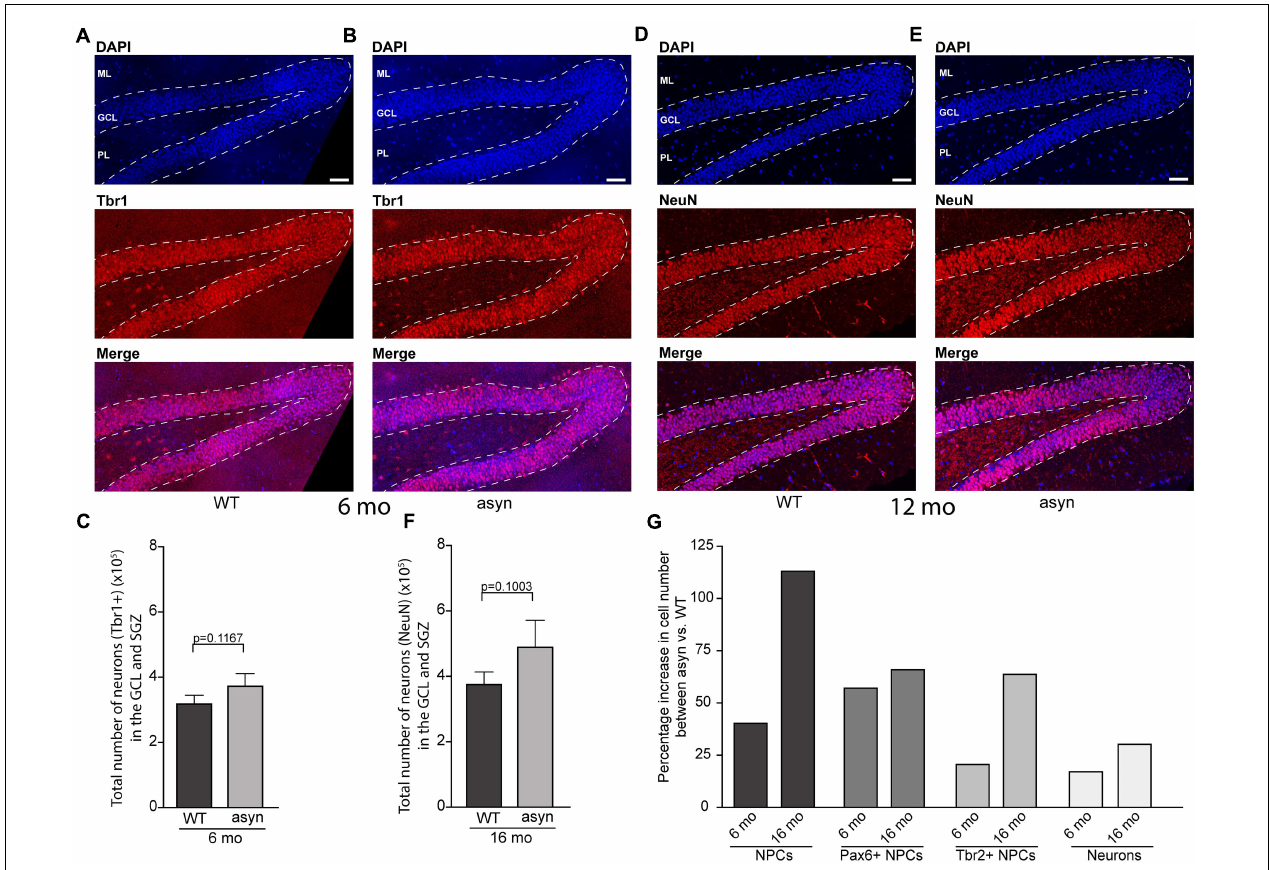
FIGURE 3 | Quantification of Tbr1 and NeuN positive cells in the hippocampal dentate gyrus of wildtype and Thy1-aSyn mice. (A,B) Immunofluorescence for Tbr1 (red) and DAPI staining (blue) and merged images of 6-month-old wildtype [WT, (A) ] and Thy1-aSyn [asyn, (B) ] mice. Number of Tbr1 + cells (C) in the granular cell layer (GCL) and subgranular zone (SGZ) of 6-month (mo)-old wildtype (WT) and Thy1-aSyn (asyn) mice. (D,E) Immunofluorescence for NeuN (red) and DAPI staining (blue) and merged images of 16-month-old wildtype [WT, (D) ] and Thy1-aSyn [asyn, (E) ] mice. Number of NeuN + cells (F) in GCL and SGZ of 6 month-old wildtype (WT) and Thy1-aSyn (asyn) mice. (G) Change (percent) in number of PCNA+, Pax6+/PCNA+, Tbr2+/PCNA+ cells and neurons between 6 and 16 month-old Thy1-aSyn (asyn) and wildtype (WT) mice. Data represent mean ± SEM. (WT; 6 month-old, n = 6, 16 month-old n = 6; asyn, 6 month-old, n = 6, 16 month-old n = 5; Student’s t -test). Scale bars, 50 µ